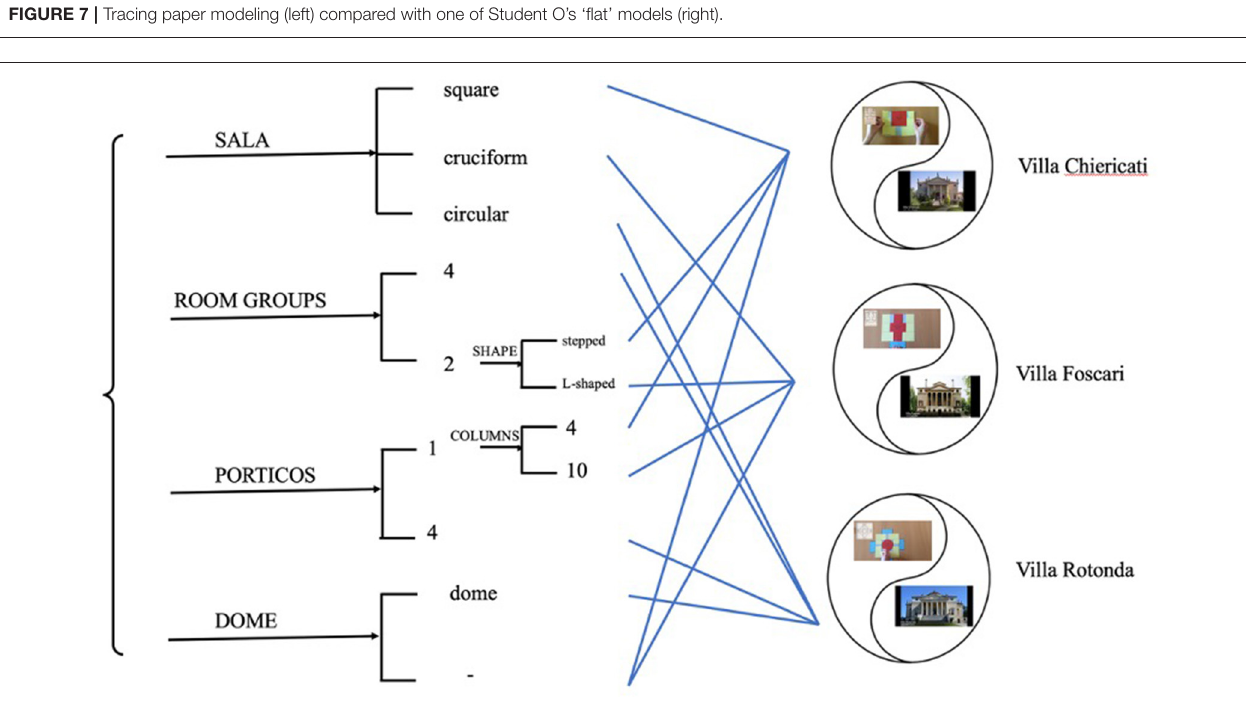
FIGURE 8 | Student O’s closed system with three realizations at the rank of ensemble.